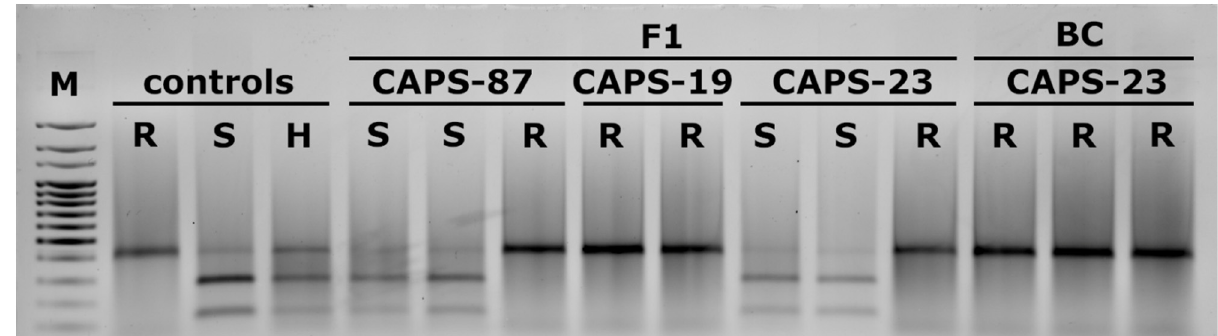
Figure 7. Restriction pattern of CAPS marker for identification of the L4 allele conferring resistance to PMMoV in F1 and BC regenerants. Controls represent diploid genotypes. R—resistant (L4L4), S—susceptible (L0L0), H—heterozygous (L4L0); M—100 bp marker.